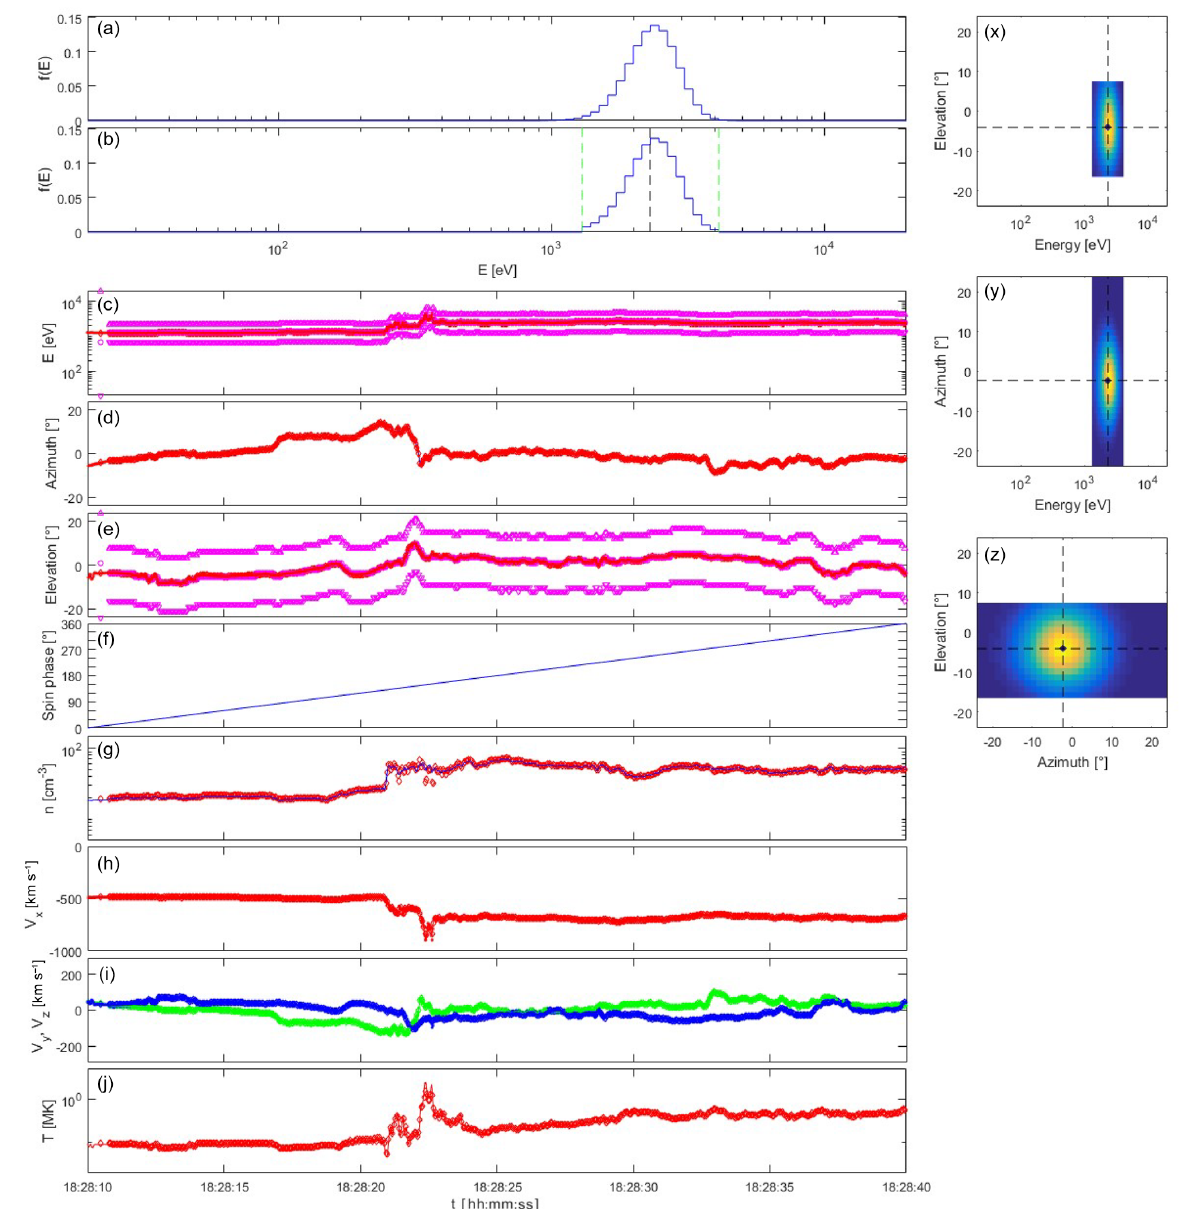
Figure 8. Plasma spectrometer measurements for a solar wind simulation based on Spektr-R/BMSW observations of a strong shock on 22 June 2015, using internal energy and elevation beam tracking. The plot layout is the same as that of Fig.